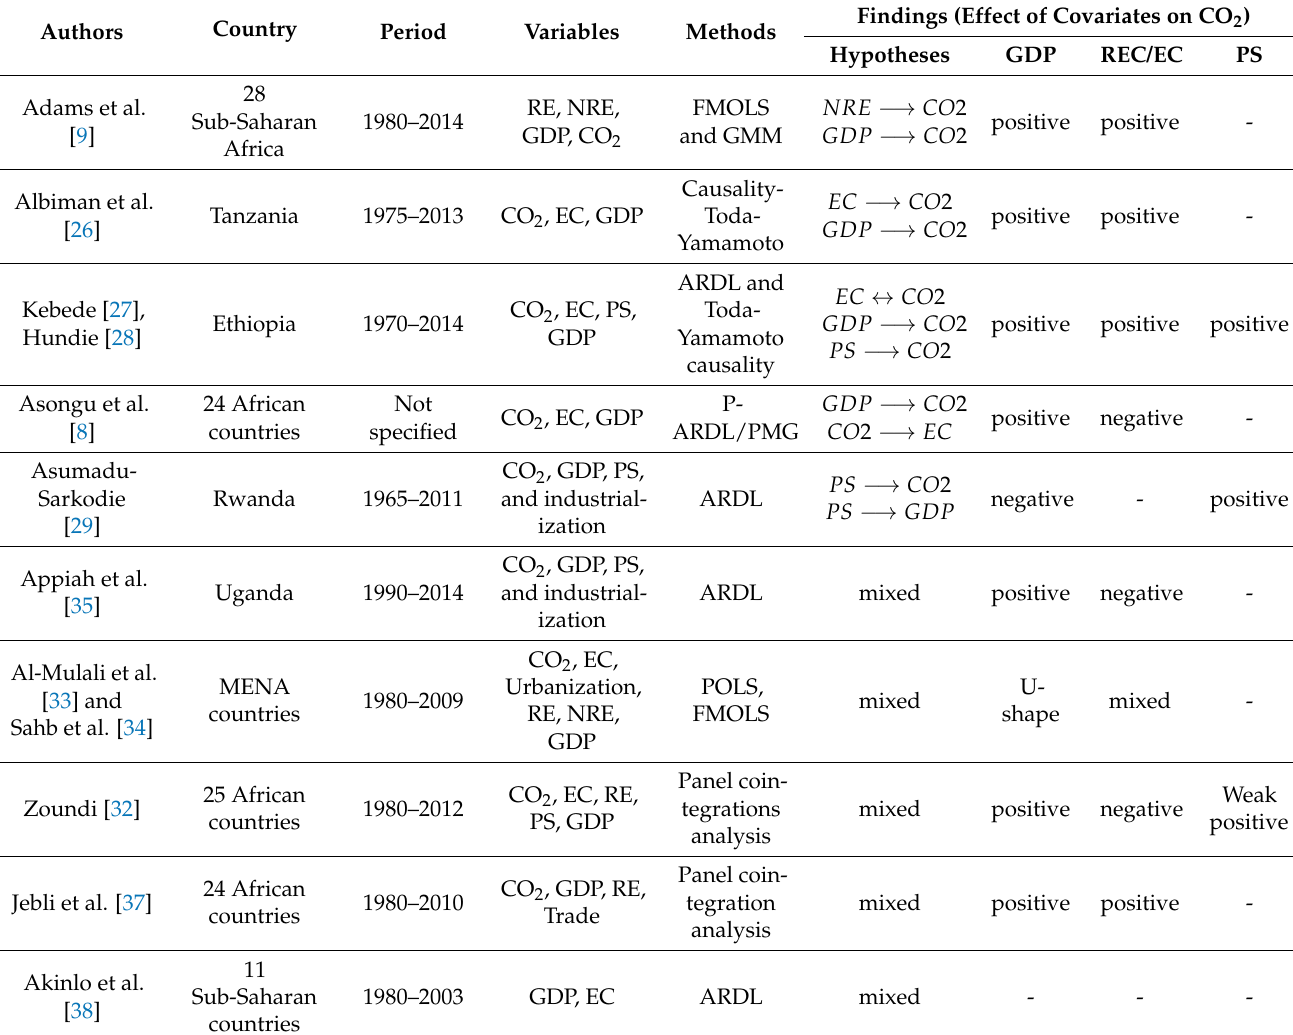
Table 1. Summary of selected existing studies on the nexus of CO 2 emissions, renewable energy, and economic and population growth for the East African